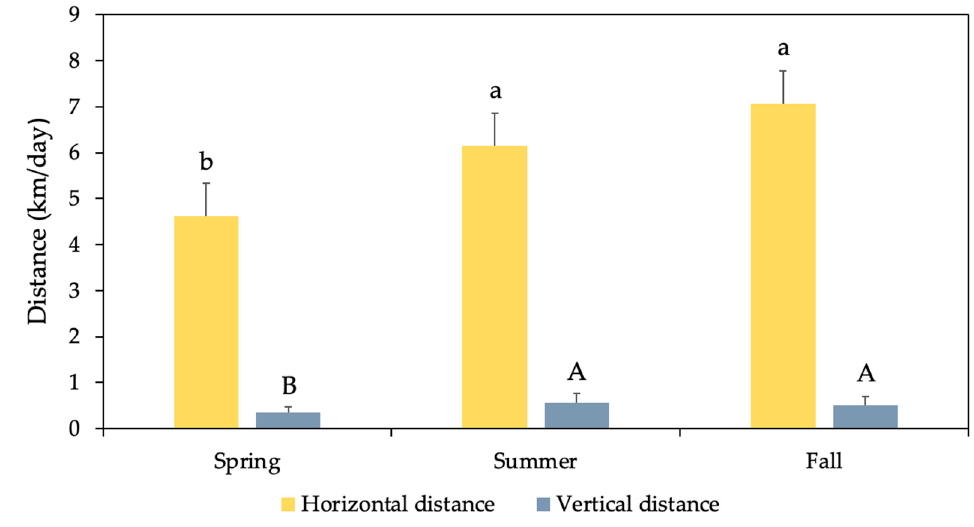
Figure 3. Seasonal variation of locomotion activity of browsing experimental goat in the studied forest rangeland of Northern Morocco. a,b horizontal, or A,B vertical distances values with different letters are significantly different ( p < 0.05).